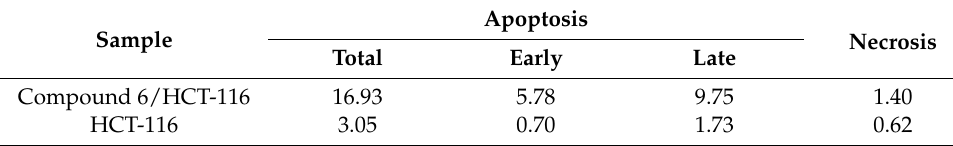
Table 3. Compound 6 induced apoptosis in HCT ‐ 116 cells.